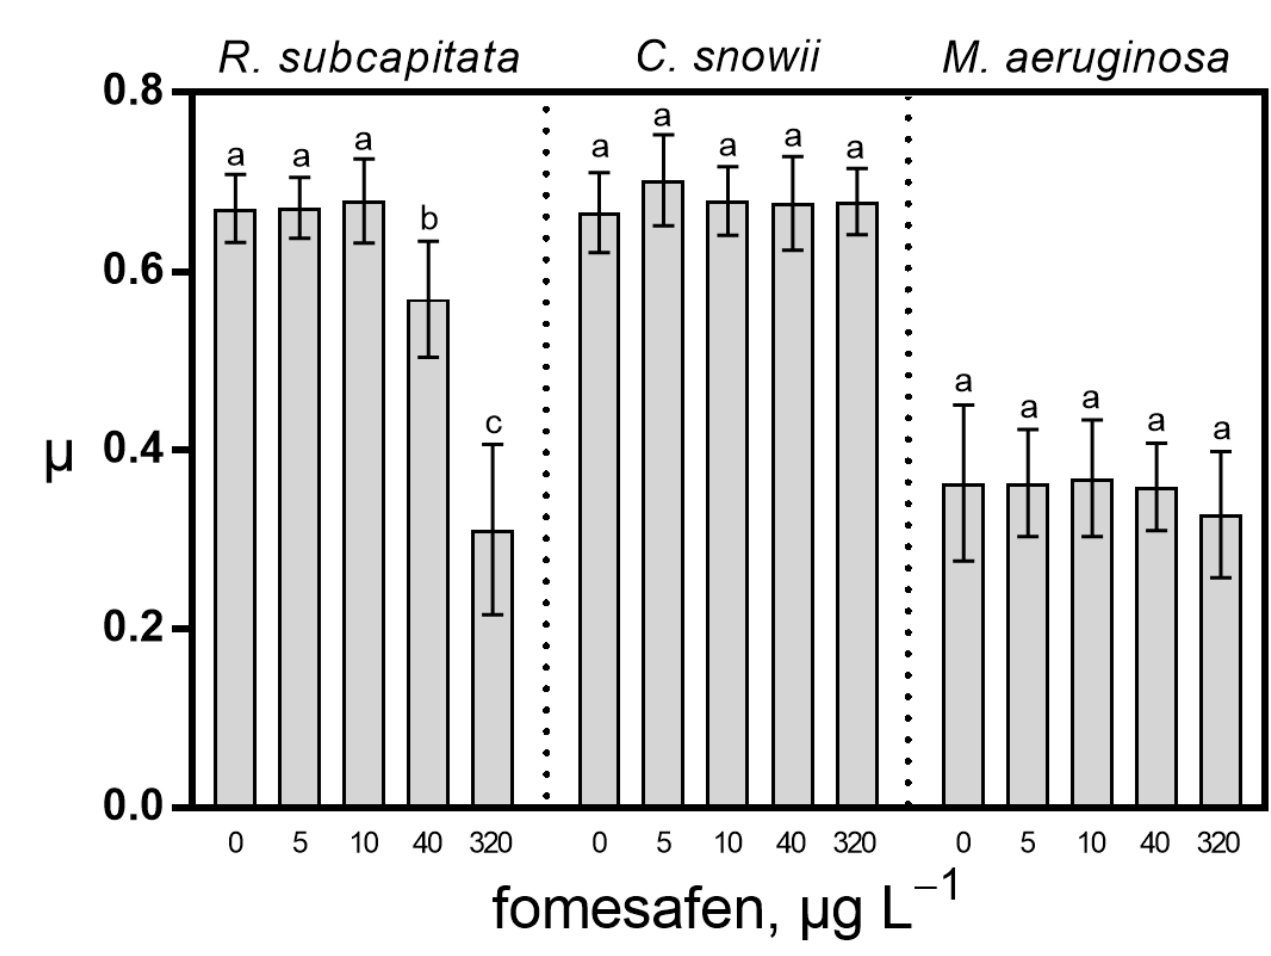
Figure 1. Growth rate ( µ ) for R. subcapitata , C. snowii and M. aeruginosa after 72 h exposure to five concentrations of fomesafen-based herbicide (Reflex ® ; 0, 5, 10, 40 and 320 µg · L − 1 fomesafen a.i.). Bars indicate the means ± standard deviation of nine replicates. Means followed by the same letter are not significantly different by the Tukey–Kramer HSD test.